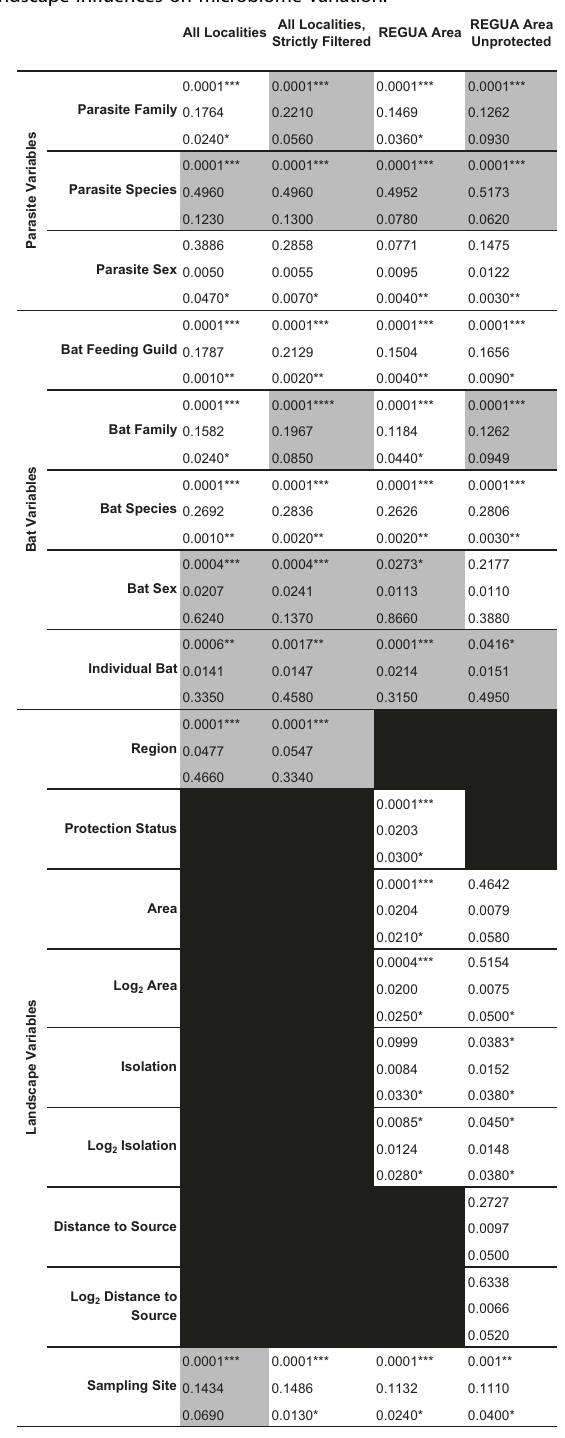
rho = 0.0020, p value = 0.9787; Distance to Source: rho = − 0.0564, p value = 0.4421; Fig. 3). Median bacterial ASV richness fell between 6 and 11 for each sampled parasite individual, but the range of ASV richness per fragment varied dramatically. There was no signi fi cant difference between sampling sites in mean ASV richness (Kruskal- Wallis chi-squared statistic = 17.856, p value = 0.1201).